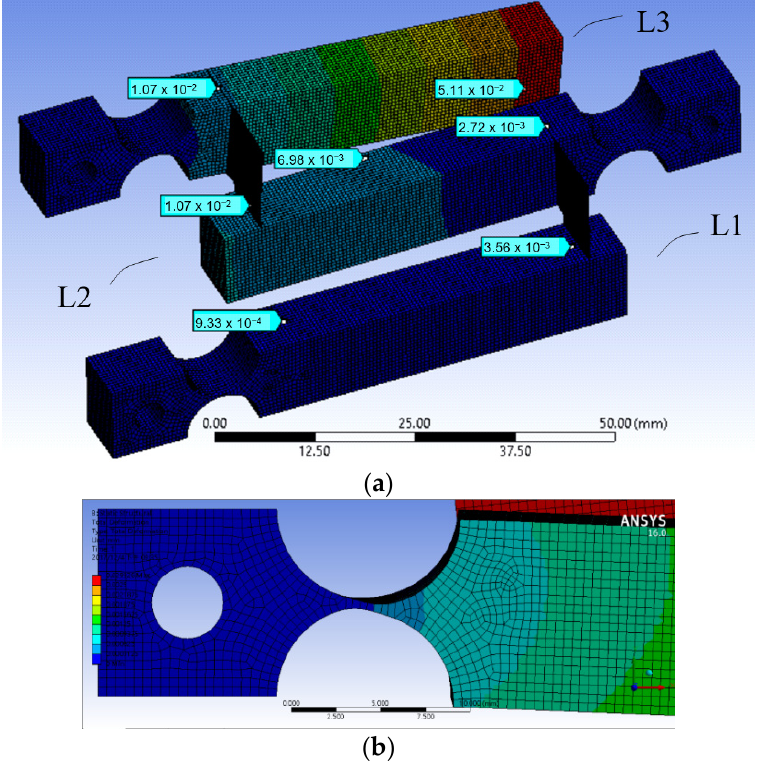
Figure 6. ( a ) A finite element model of the conceptual design B; ( b ) undesired shear deformation found in one of the monolithic hinges.